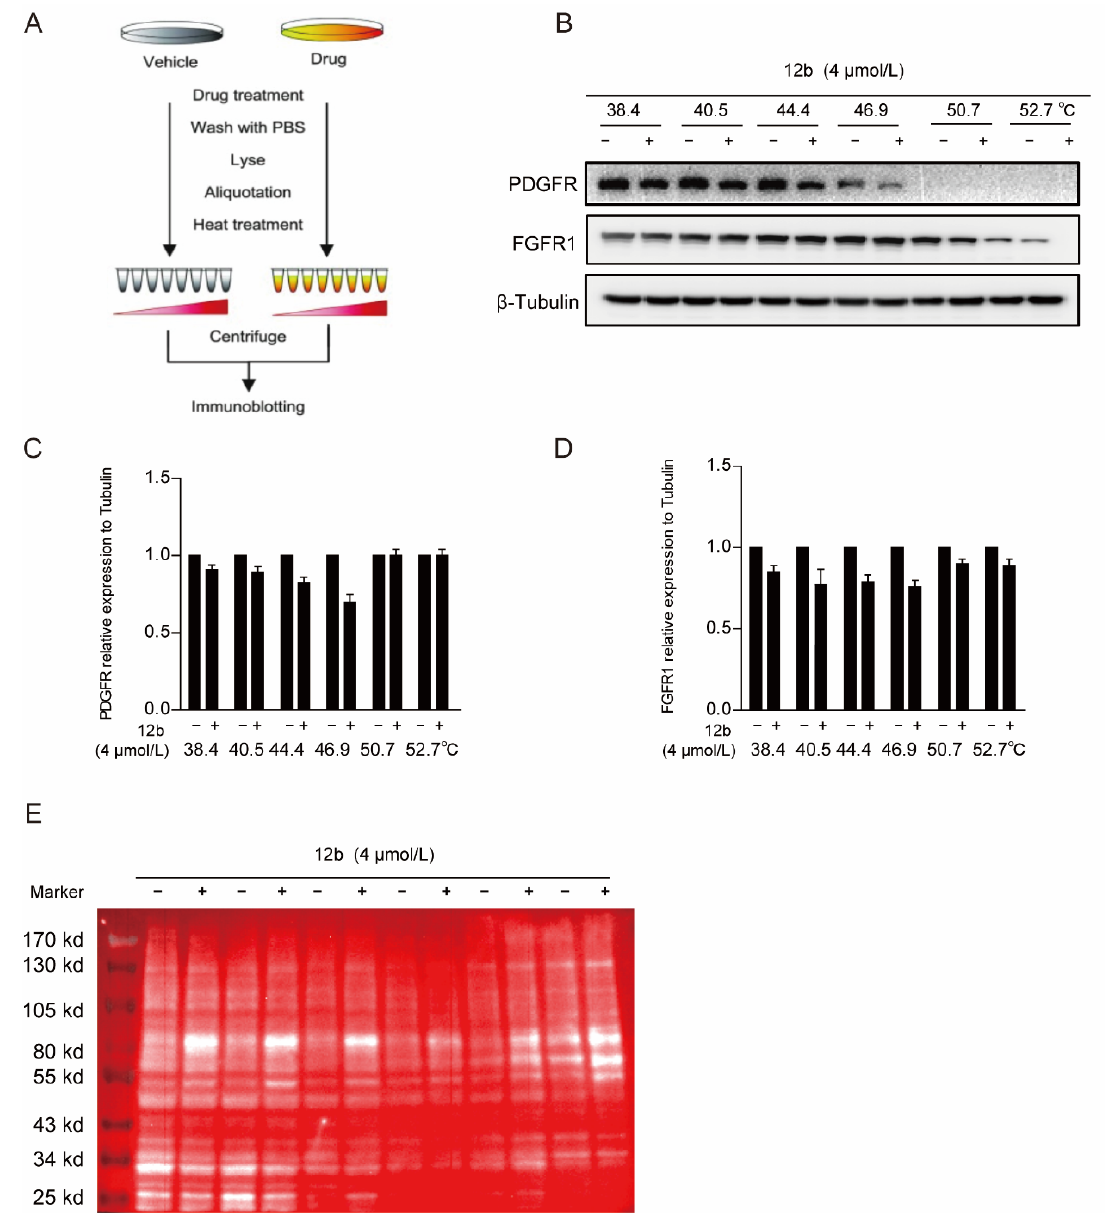
Figure 5. 12b bind to a glycoprotein containing α , β -D galactose. ( A , B ) Effect of 12b on RTK proteins stabilization. MDA-MB-231 cells were treated with or without 12b (4 µ M) for 2 h before being heated at different temperatures. Protein levels were analyzed by Western blotting. ( C , D ) The relative band intensity to β -Tubulin was analyzed by ImageJ software. Protein band densities were quantified by normalizing to DMSO. ( E ) The samples in ( A ) were taken for immunoblotting, membranes were incubated with the RCA I antibody, and HRP-Streptavidin antibody. Signals were detected by